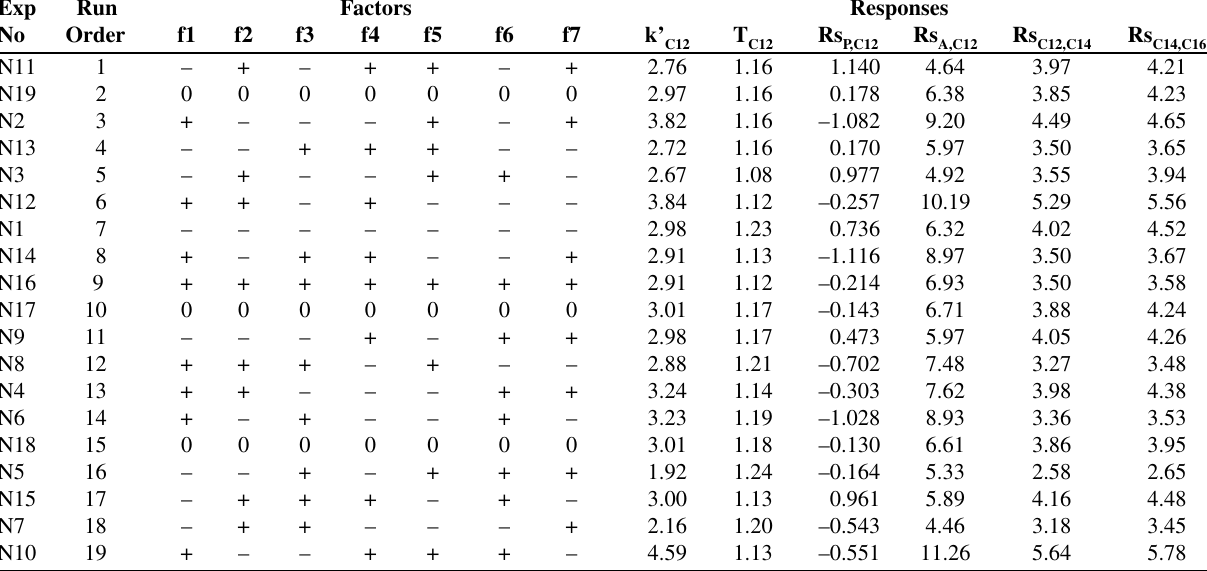
Table 3. Randomized 2 7–3 fractional factorial design and results of observed responses. Exp Run